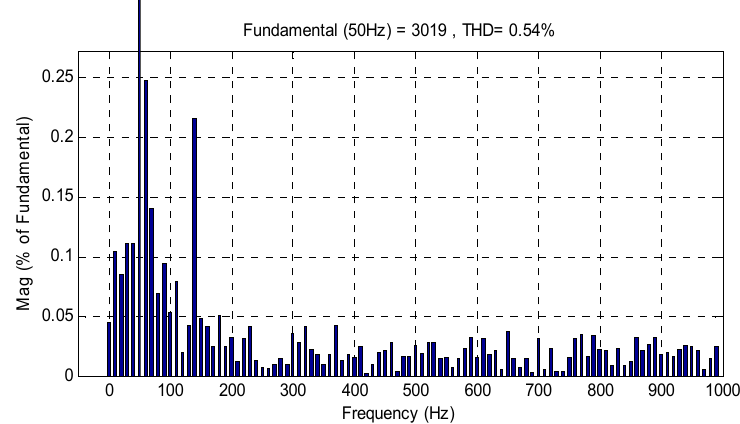
Fundamental (50Hz) = 3023 , THD= 0.19%